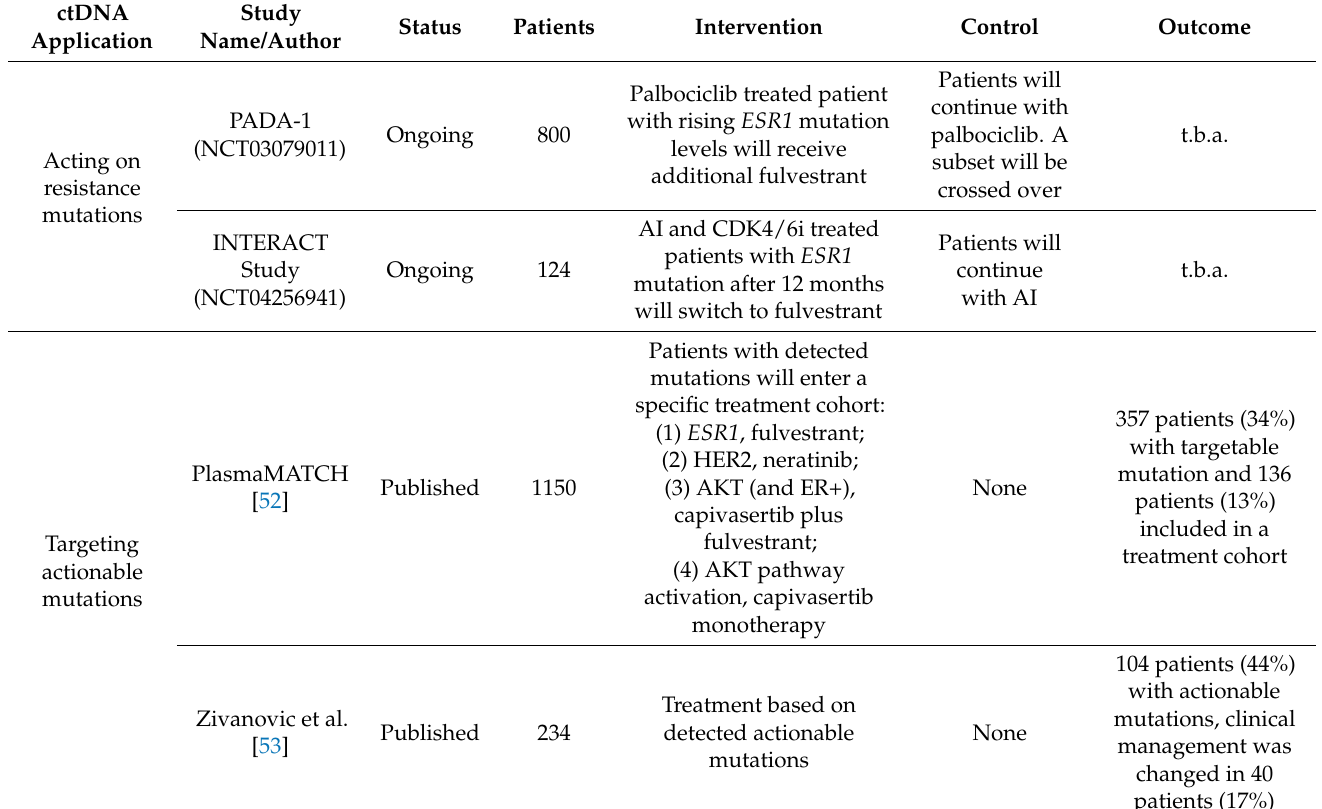
Table 3. Ongoing studies focusing on clinical utility of ctDNA in metastatic breast